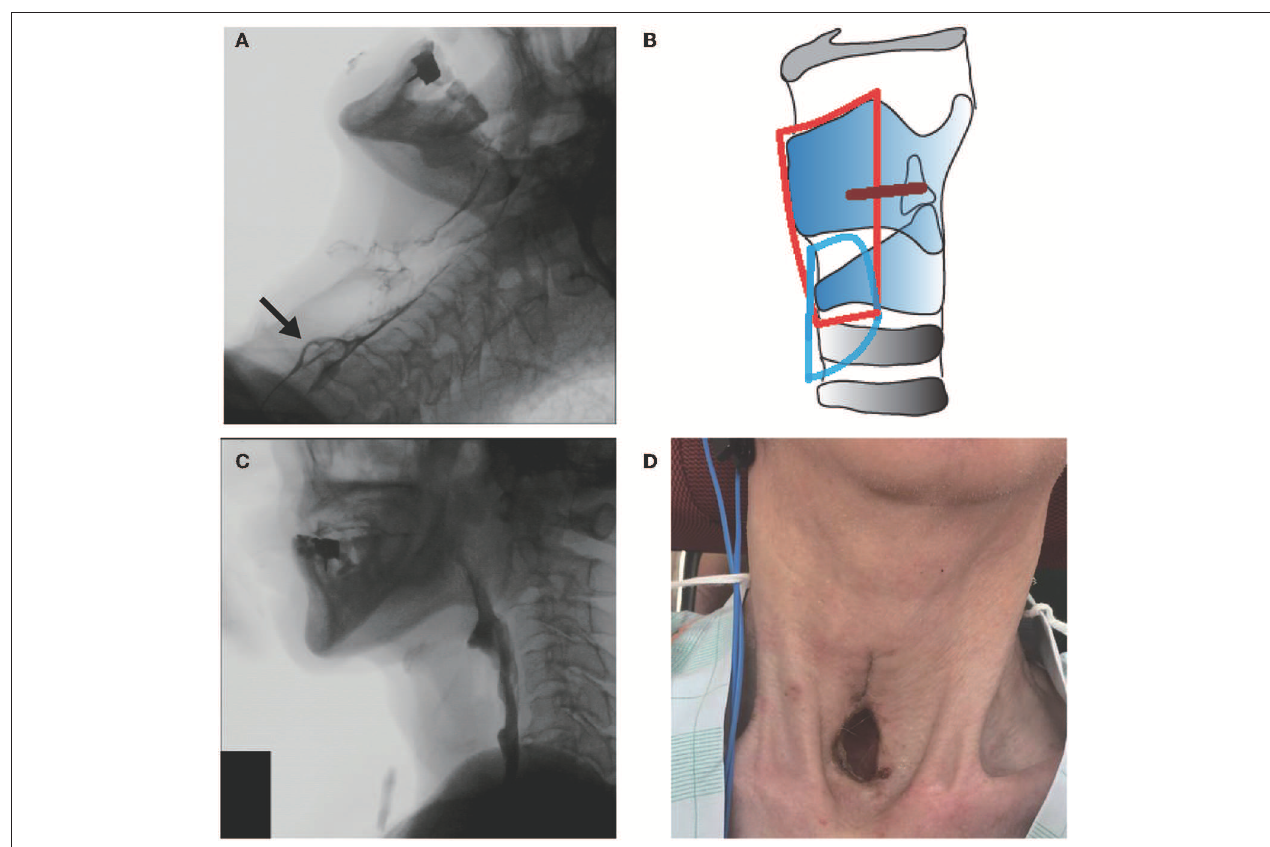
FIGURE 2 | Clinical findings in case 2. (A) Preoperative videofluoroscopic swallowing study (VFSS). The arrow shows contrast agent aspiration into the trachea during swallowing. (B) Operative schema. The removed area is encircled by a red line, and the place of the permanent tracheostoma is encircled by a blue line. The glottic closure site is shown as a brown line. (C) Postoperative VFSS. (D) View of the permanent tracheostoma without a